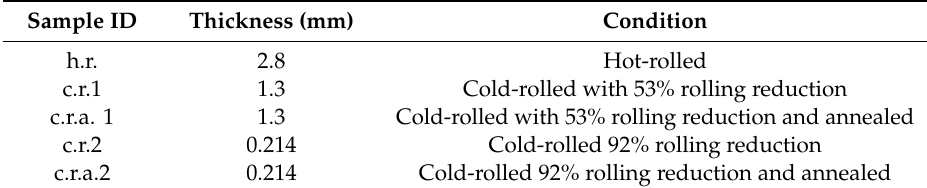
Table 1. Description of examined samples.